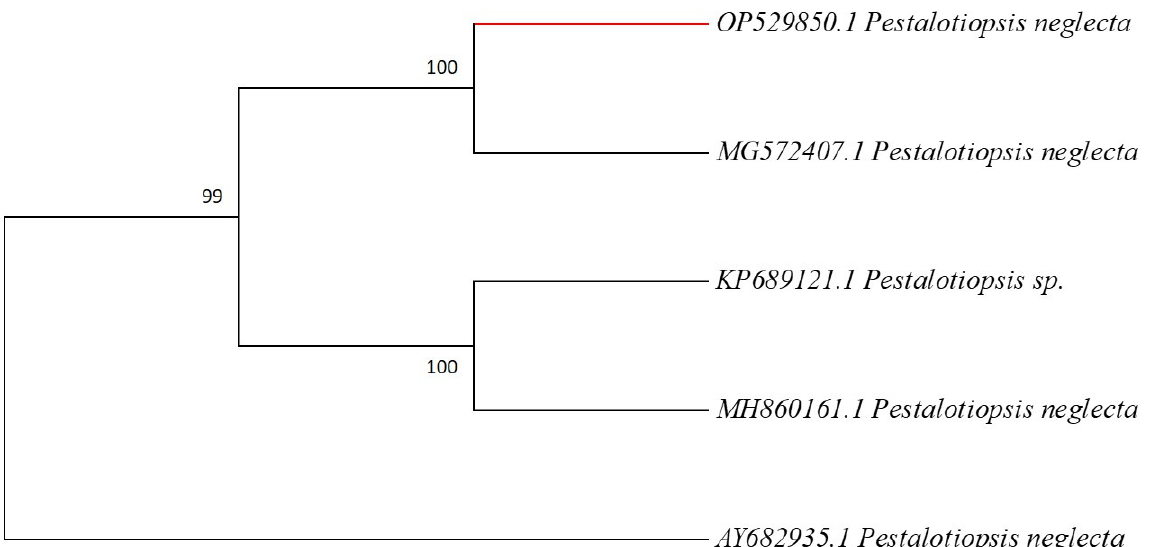
Figure 1. Phylogenetic tree based on the 5.8S-rRNA-ITS regions between the endophytic fungus P. neglecta and published data and evolutionary distances computed using the Maximum Likelihood method.